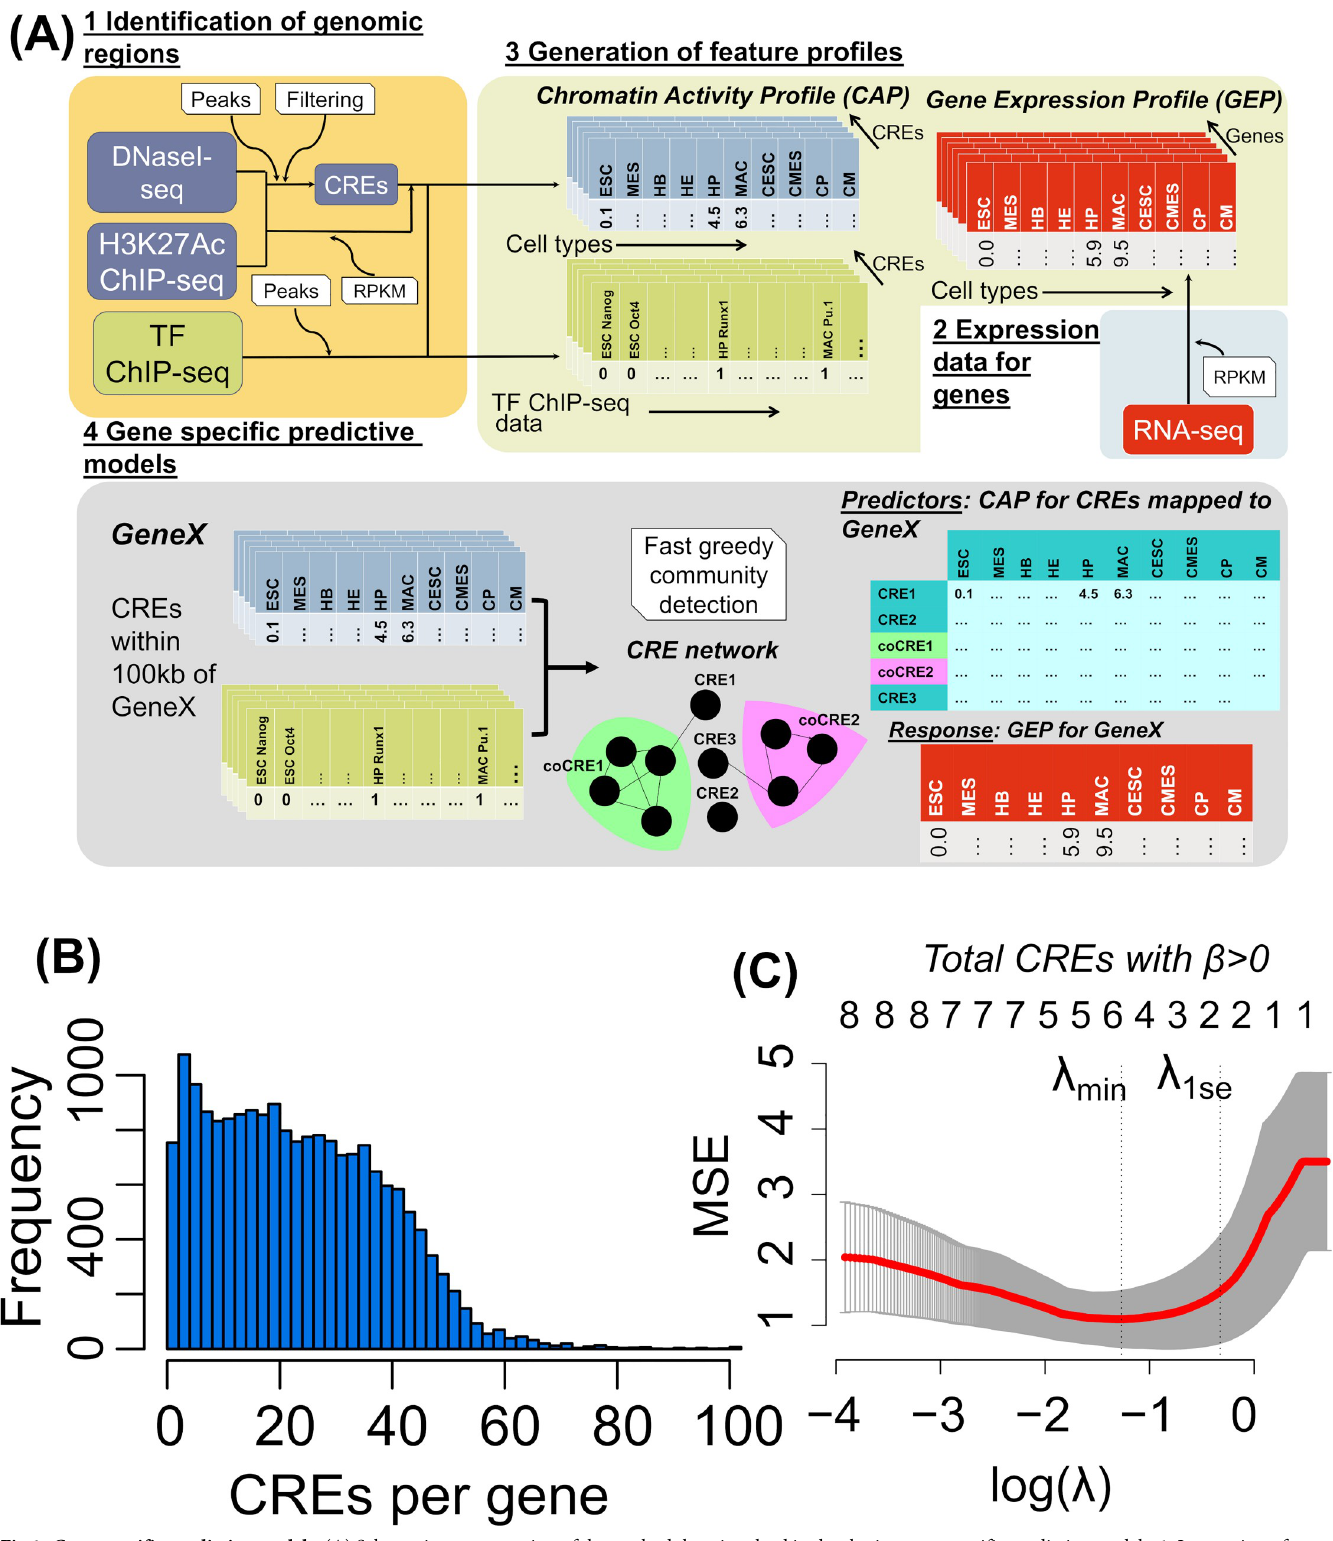
Fig 1. Gene-specific predictive models. (A) Schematic representation of the methodology involved in developing gene specific predictive models. 1. Integration of DNaseI-seq and H3K27ac to quantify the chromatin activity profile (CAP) in candidate cis regulatory elements (CREs). TF ChIP-seq data is used to generate the